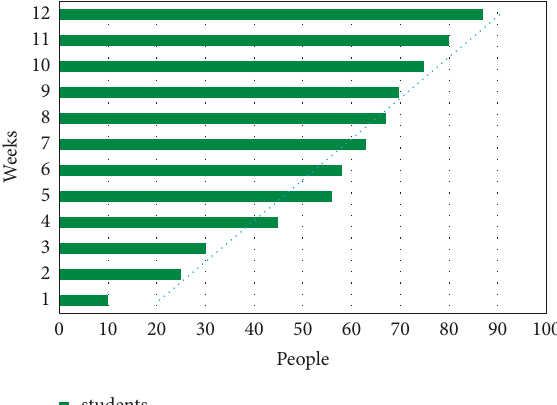
Figure 6: Group B was found to be unable to express its emotions